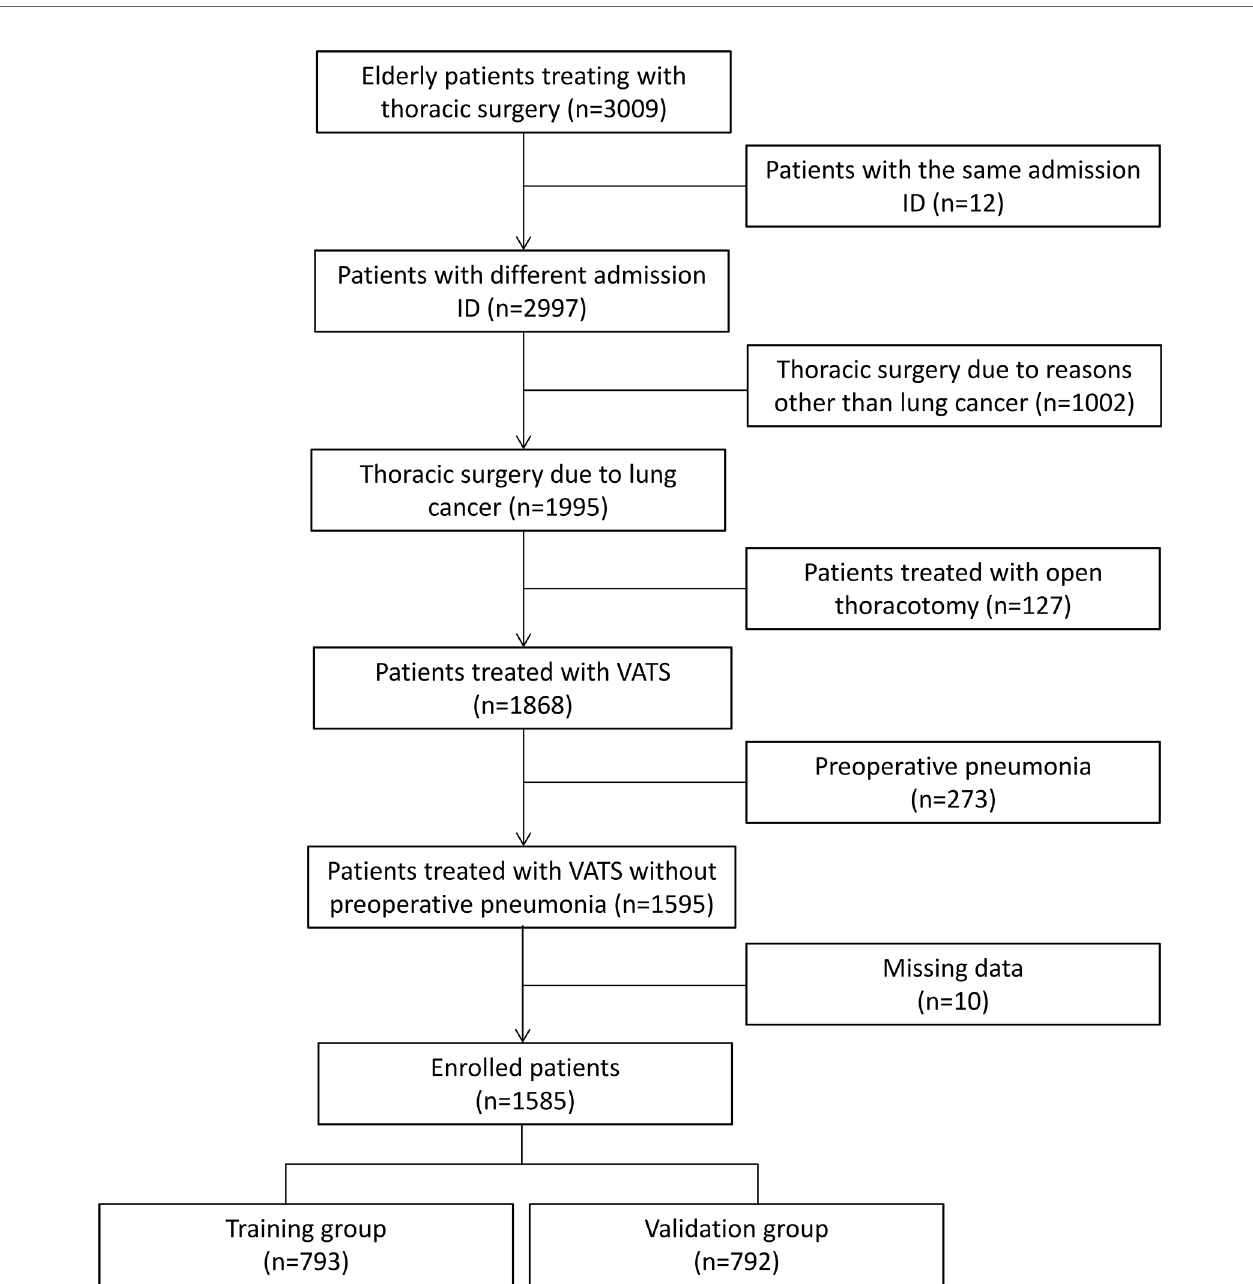
FIGURE 1 | Patient ’ s fl ow chart. The enrolled patients were randomly divided into the training group and the validation group. VATS indicates video-assisted thoracoscopic